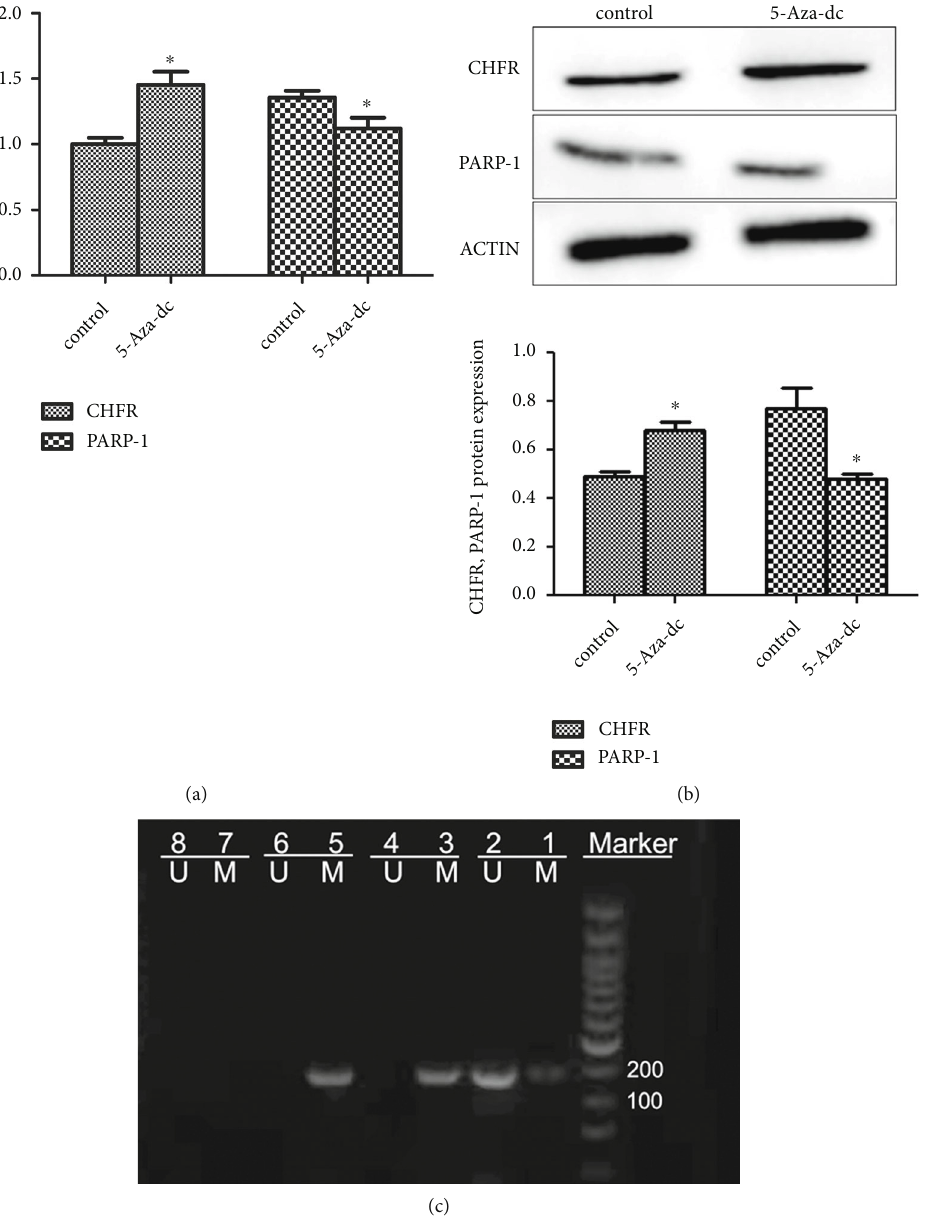
Figure 2: The e ff ects of 5-Aza-dc on the expression levels of CHFR and PARP-1, as well as CHFR methylation in Raji cells. (a) The mRNA expression levels of PARP-1 and CHFR in the cells treated with 5-Aza-dc for 24 hours determined by real-time quanti fi cation PCR (RT- qPCR). (b) The protein expression levels of PARP-1 and CHFR in the cells treated with 5-Aza-dc for 24 hours measured by western blotting. (c) The methylation of CHFR in Raji cells using methylation speci fi city-PCR (MSP; M: methylation; U: unmethylation; 1, 2: treatment group, the Raji cells treated with 5-Aza-dC; 3, 4: control group, the Raji cells treated with PBS; 5, 6: positive control group, the normal peripheral blood treated with SssI methyl transferase; 7, 8: blank control group, only the medium). * P < 0 : 05 , compared with the control